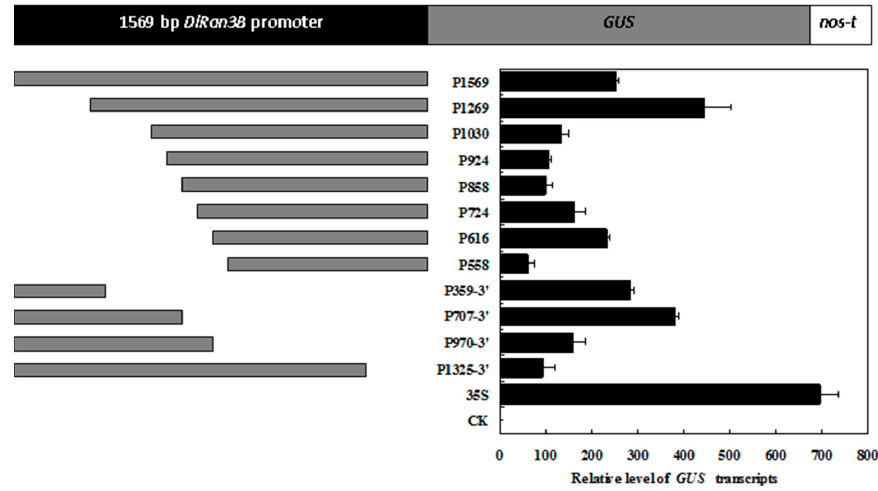
Figure 5. Schematic diagram of the DlRan3B promoter deletion constructs. 35S represents the samples with pBI121 vector, and CK represents wild-type tobacco. The GUS expression level was normalized to 18SrRNA . Data are shown as means ± SD ( n = 3).